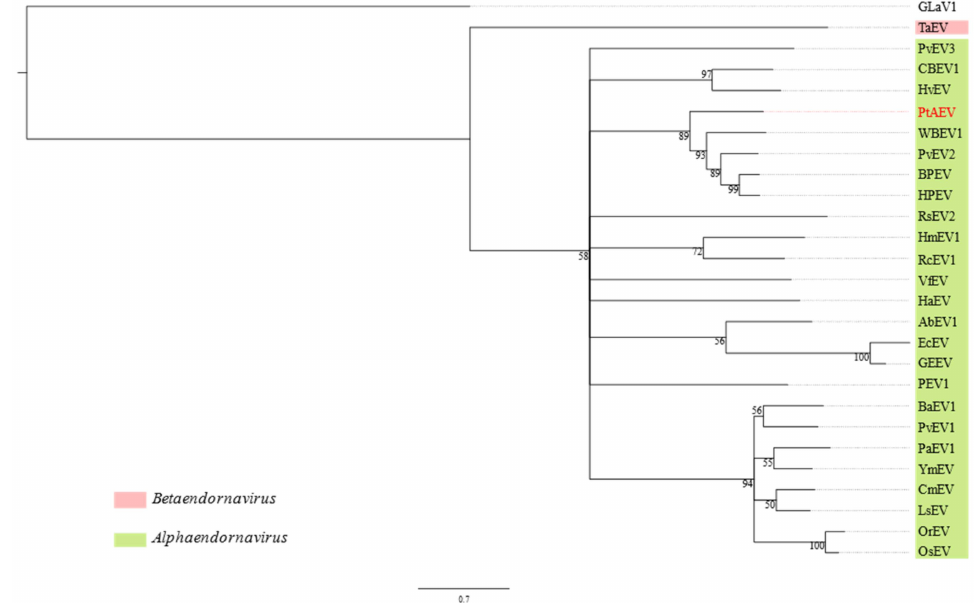
Figure 4. Maximum likelihood reconstruction of the phylogeny of alphaendornaviruses based on the RNA-dependent RNA polymerase gene. The acronym in red font corresponds to the virus discovered in this study (Table 1) and the other virus acronyms are defined in Table S4. The numbers next to the branches are non-parametric bootstrap values based on 1000 replicates. The nucleotide substitution model used for the phylogenetic tree is listed in Table